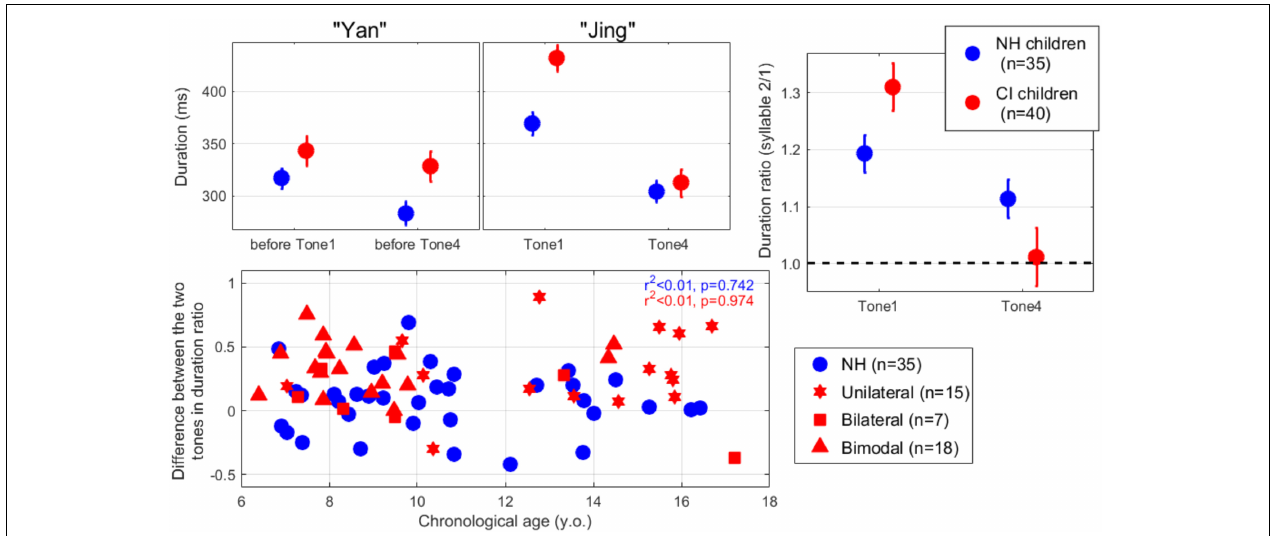
FIGURE 2 | (Top left and middle) Duration of the two syllables of “yan-jing” produced as Tone 1 or Tone 4, averaged across participants in each population. (Top right) Duration ratios between two syllables indicate that children with CIs prolonged the duration of tone 1 in order to convey what is supposedly a high-flat pitch contour. Error bars show ± 1 standard error of the mean. (Bottom) Difference in duration ratio between the two lexical tones, plotted across participants as a function of their chronological age. A greater positive value indicates a stronger tendency to prolong Tone 1 or shorten Tone 4. Regardless of their mode of hearing in everyday life, children with CIs were tested only a single (implanted)